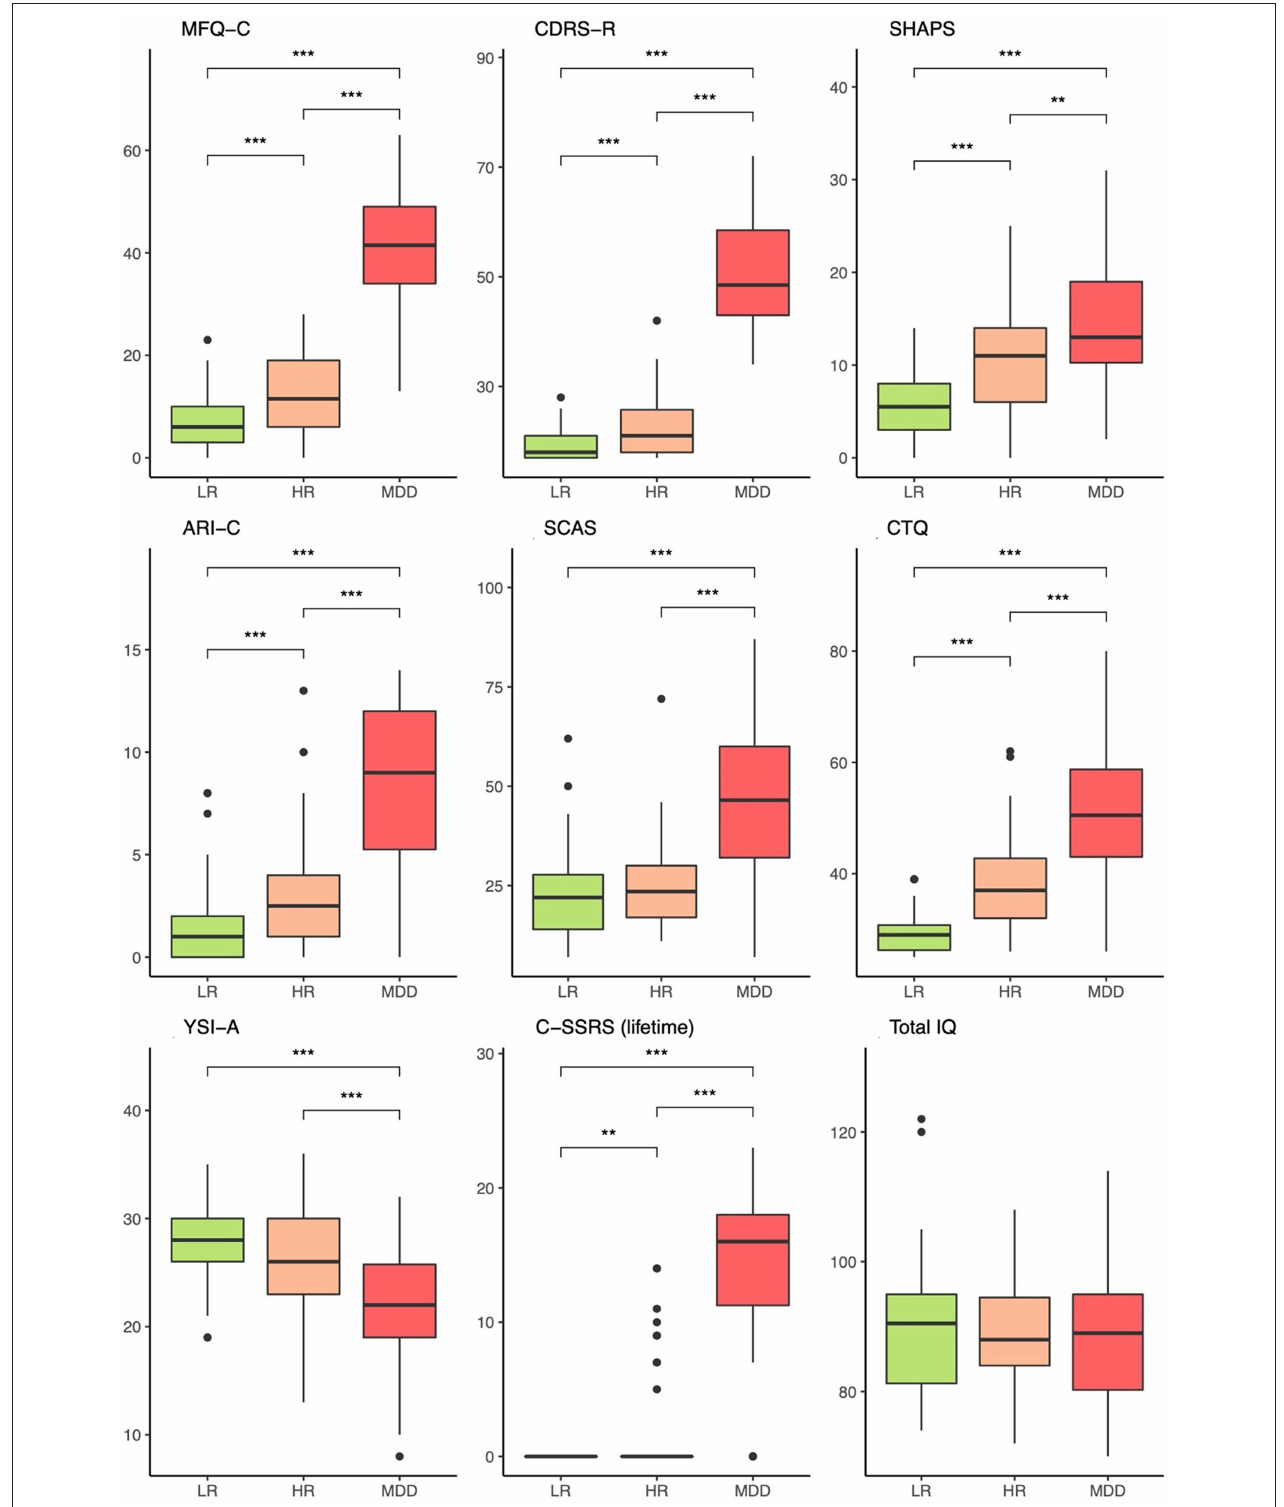
FIGURE 8 | Phenotypic comparisons between groups based on reports by the adolescents. LR, low-risk; HR, high-risk; MDD, major depressive disorder; MFQ-C, Mood and Feelings Questionnaire—Child; CDRS-R, Children’s Depression Rating Scale Revised; SHAPS, Snaith-Hamilton Pleasure Scale; ARI-C, Affective Reactivity Index—Child; SCAS-C, Spence Children’s Anxiety Scale; CTQ, Child Trauma Questionnaire; YSI-A, Youth Strengths Inventory—Adolescent; C-SSRS, Columbia-Suicide Severity Rating Scale. CDRS-R ratings were based on information from both adolescent and caregiver, with priority to the former. The non-parametric Kruskal-Wallis test was applied to compare the means. ** p < 0.01, *** p < 0.001.